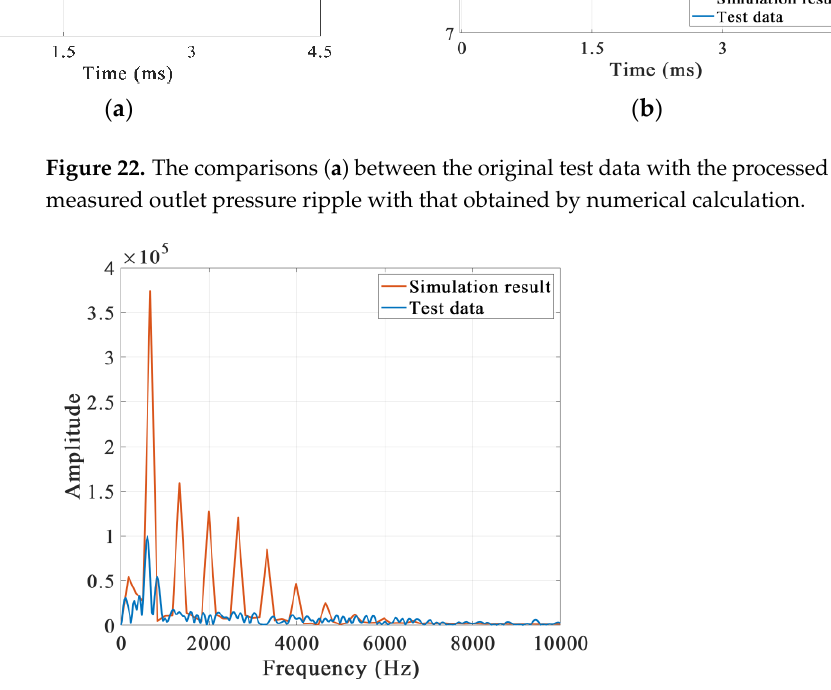
Figure 23. Frequency spectrograms of the test data and simulation result.